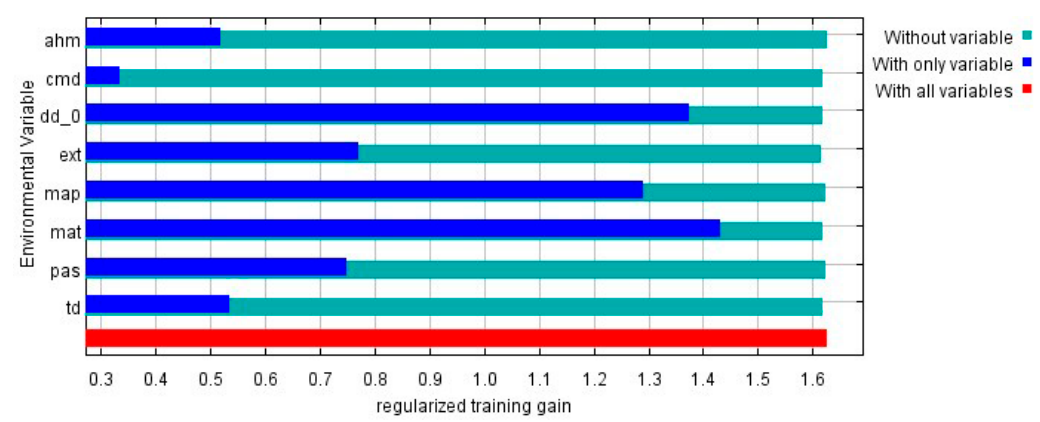
Figure A1. This picture is the receiver operating characteristic (ROC) curve of the camphor tree habitat distribution model. The red curves shown are the averages over 10 replicate runs. The average test AUC for the replicate runs is 0.923, and the standard deviation is 0.010.